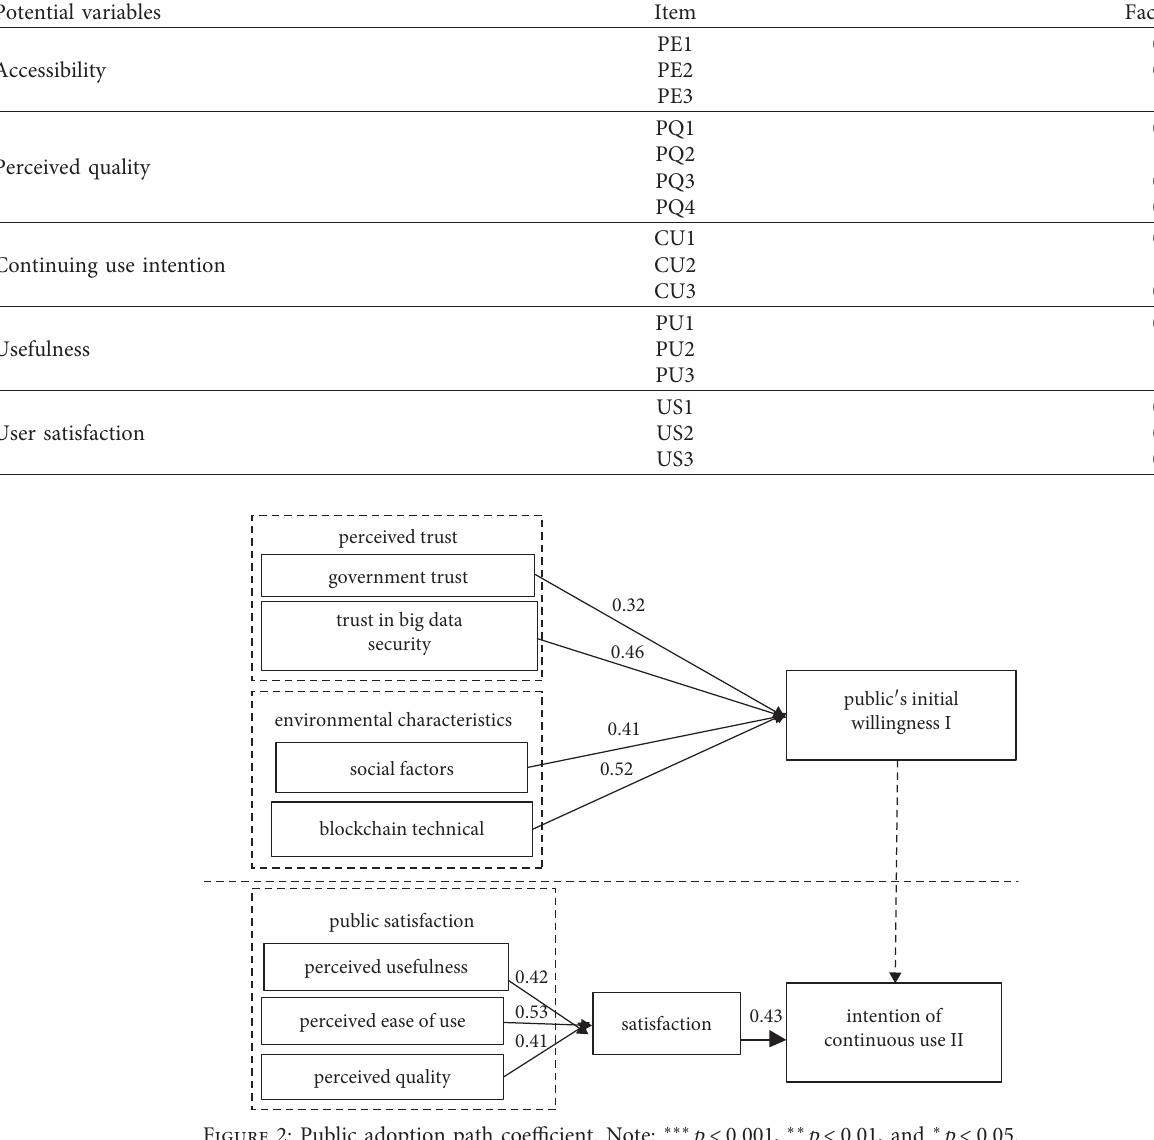
Table 5: Principal component factor load during continuous use.